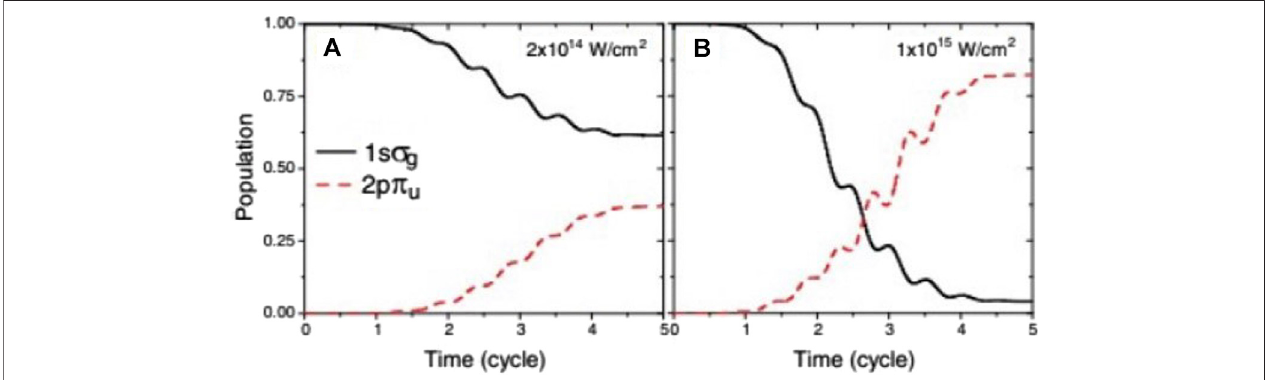
FIGURE 2 | Time-dependent probability density D ( t ) for in-plane excitation of (black solid line) the ground 1 s σ g state and of (red dashed line) the excited 2 p π u by λ (cid:1) 70 nm ( ω (cid:1) 0 . 65 au) and 580 as FWHM circularly polarized UV laser pulses at two different pulse intensities: (A) I (cid:1) 2 × 10 14 W/cm 2 and (B) I (cid:1) 1 × 10 15 W/cm 2 . 1 1 1-cycle (cid:1) 234